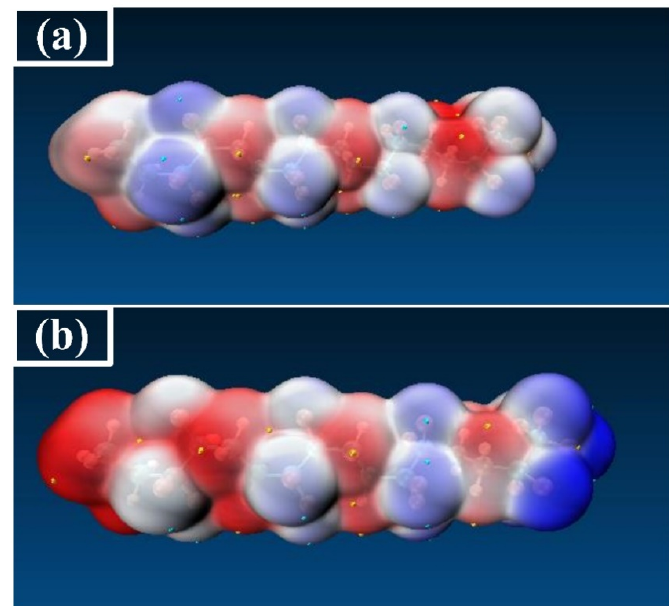
Figure 10. The electrostatic potential surface of PVDF.